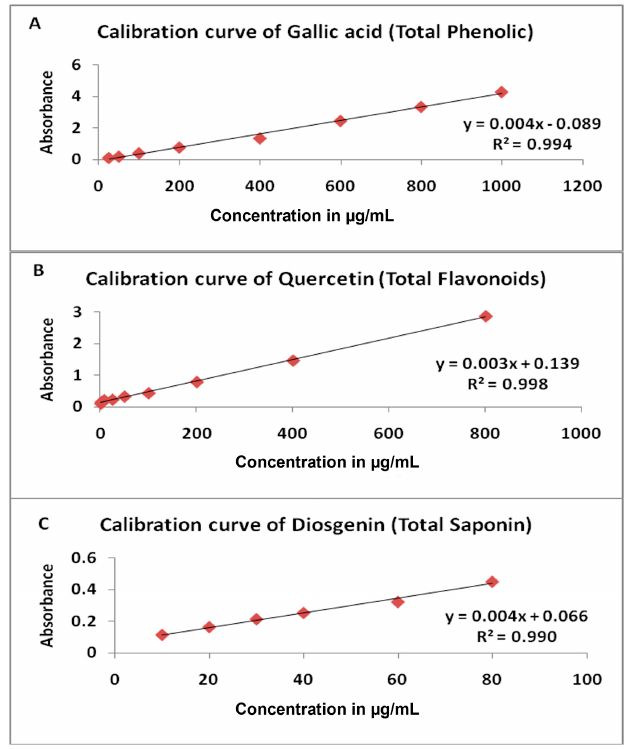
Figure 1. Standard calibration curve ( A ) Gallic acid, ( B ) Quercetin, ( C ) Diosgenin.